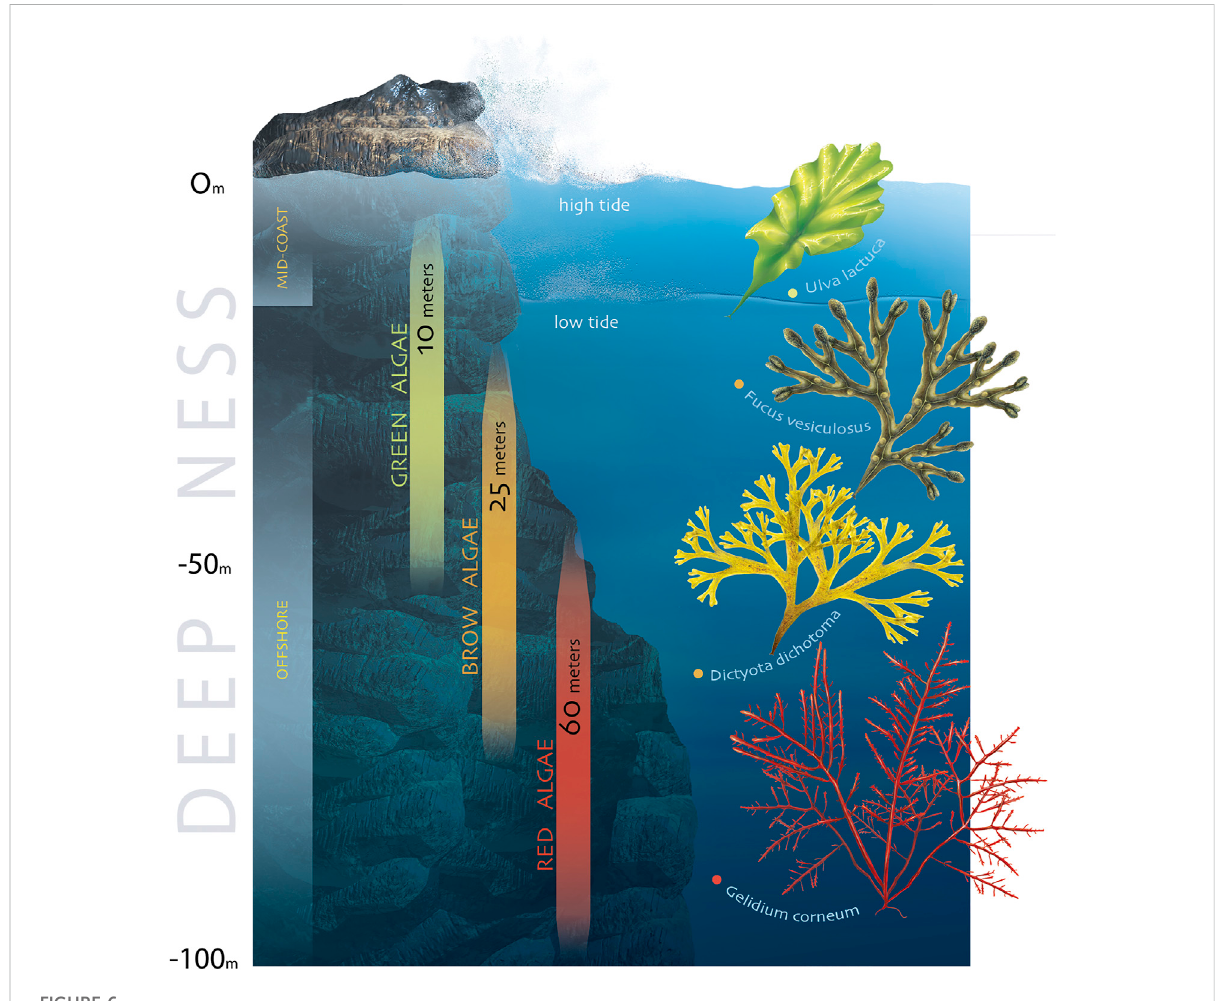
FIGURE 6 Distribution of main seaweed species in coastal